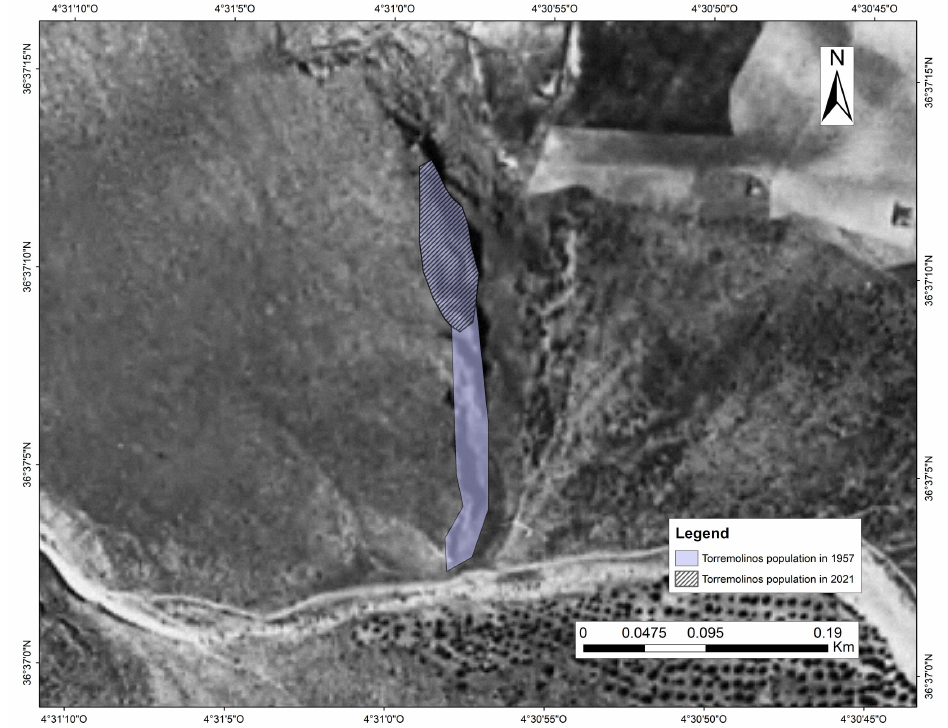
Figure 8. Torremolinos 5220* HCI: Current and 1956–57 potential